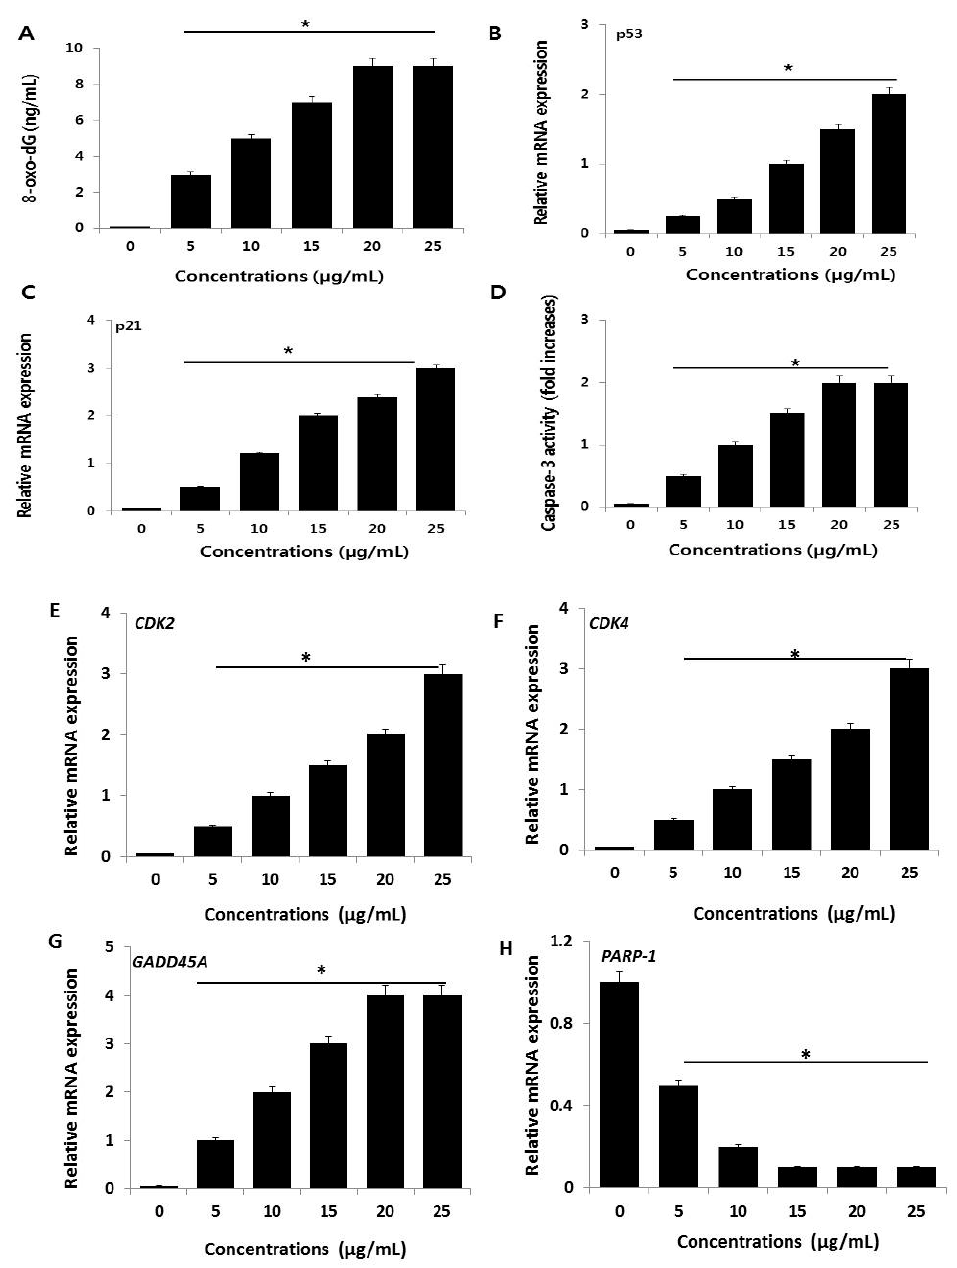
Figure 10. AgNPs induce DNA damage and increase expression of p53 and p21 genes in NIH3T3 cells. ( A ) 8-oxo-dG was measured after 24 h of exposure of NIH3T3 cells. AgNPs significantly increased oxidative DNA damage as evidenced by significant increases in 8-oxo-dG expressions. ( B , C ) Relative mRNA expression of p53 and p21 was analyzed using qRT-PCR in NIH3T3 cells treated with various concentrations of AgNPs for 24 h. ( D ) Caspase-3 activity was measured in AgNP-treated NIH3T3 cells. The results are expressed as the mean ± standard deviation of three separate experiments. ( E – H ) Relative mRNA expression of CDK2 , CDK4 , GADD45A and PARP-1 was analyzed using qRT-PCR in NIH3T3 cells treated with various concentrations of AgNPs for 24 h. There was a significant difference in the ratio of AgNP-treated cells compared to untreated cells according to a Student’s t -test (* p <